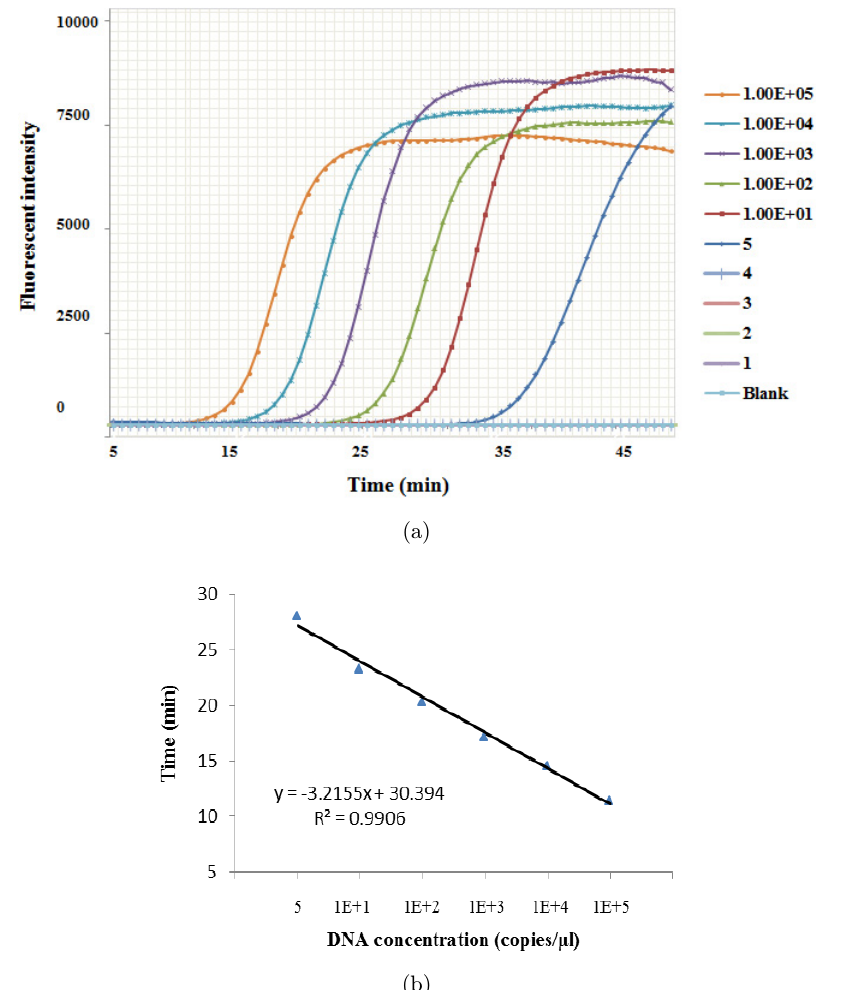
Fig. 3. (a) Sensitivity analysis of the isothermal ampli¯cation assay on the micro°uidic chip. (b) Quanti¯cation analysis of the isothermal ampli¯cation assay on the micro°uidic